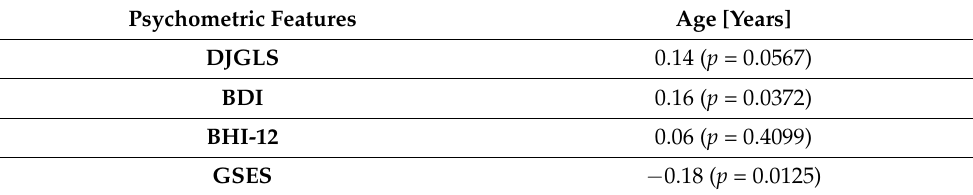
Table 4. Correlations between the applied psychometric scales and age. Psychometric Features